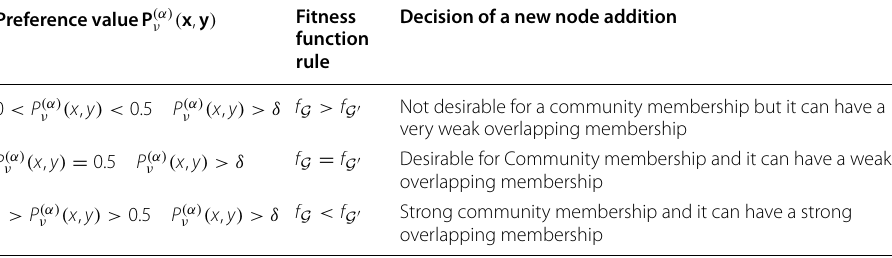
Table 3 Preference rule table: rule for the new node addition in the subgraph based on the threshold ν value and preference value Fitness Decision of a new node addition function rule Not desirable for a community membership but it can have a very weak overlapping membership Desirable for Community membership and it can have a weak overlapping membership Strong community membership and it can have a strong overlapping